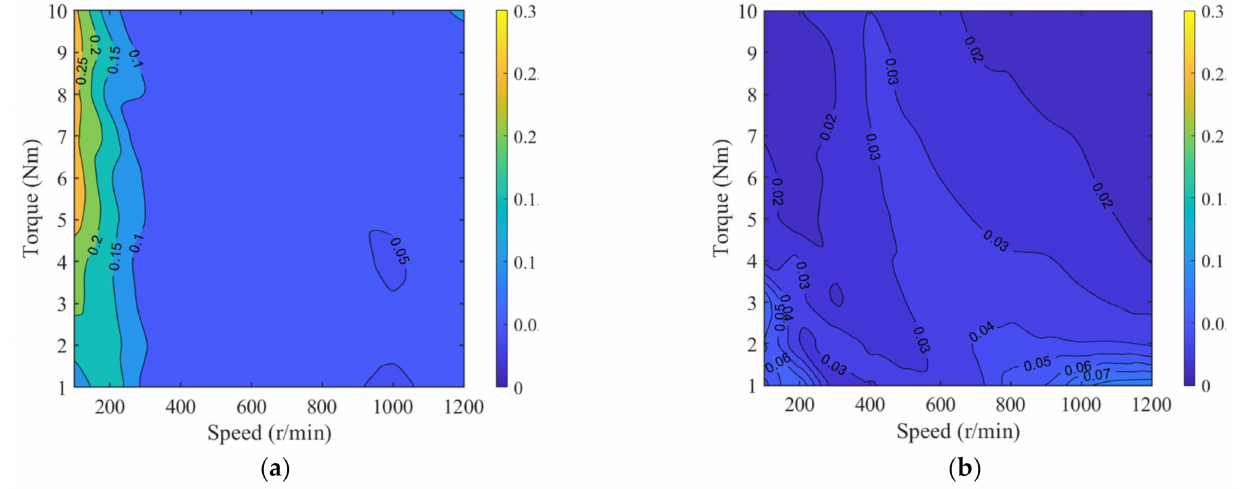
Figure 9. The speed standard deviation: ( a ) SMC system with the FPRL; ( b ) SMC system with the